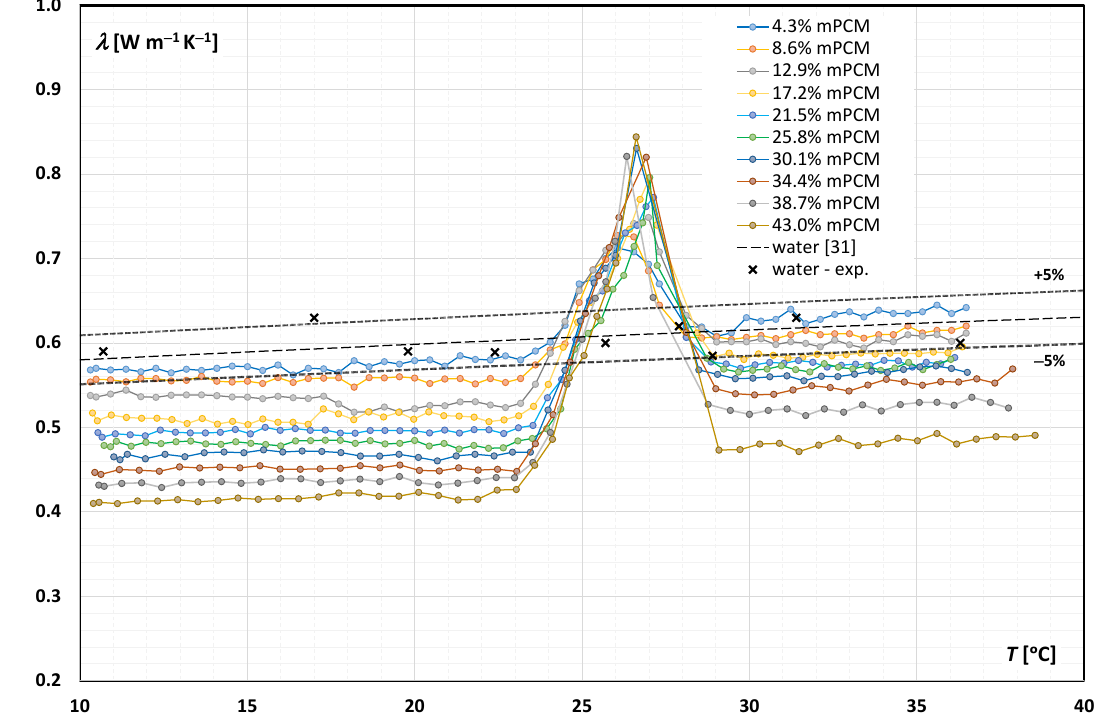
Figure 2. Thermal conductivity of mPCM aqueous slurry as a function of temperature. Table 2. Thermal-conductivity coefficient data for water according to Standard Reference Data—NIST [30].